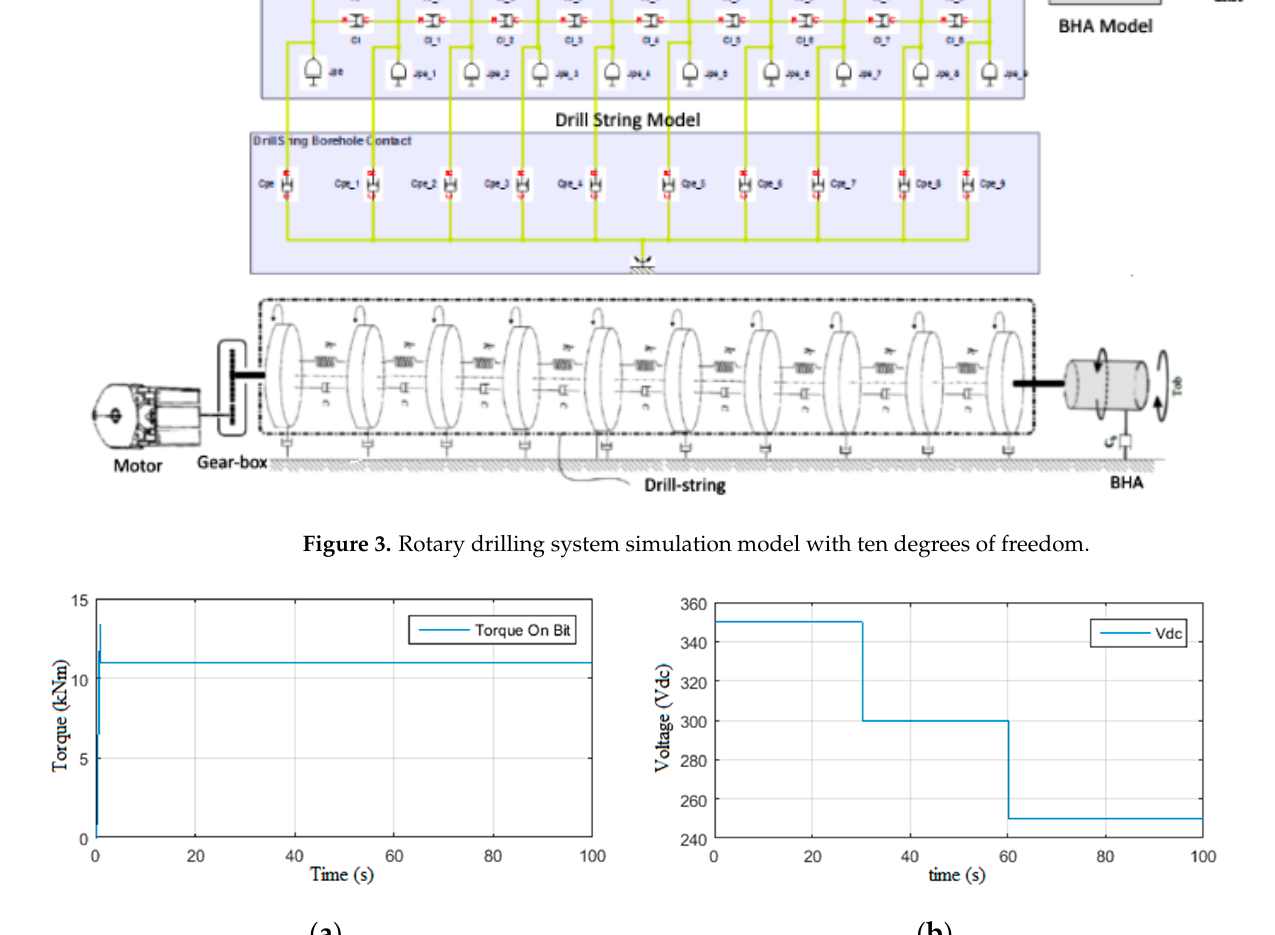
Figure 3. Rotary drilling system simulation model with ten degrees of freedom.